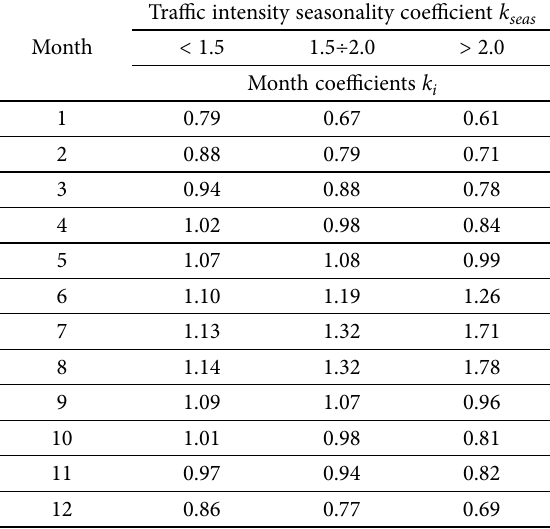
Table 1. Coefficients used for calculating average daily traffic intensities during a month (MADT) from AADT